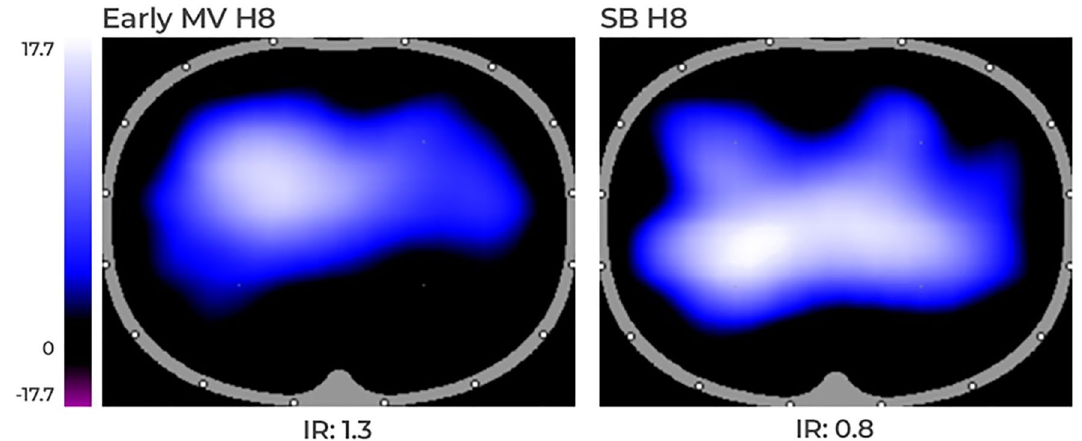
Figure 5. Representative images of an animal from the SB-group (right) and another from the Early MV group (left). The pulmonary ventilation distribution assessed by electric impedance tomography showed that SB presented dorsal predominant ventilation, as is shown by the impedance ratio = 0.8; in contrast, Early MV ventilation was predominantly ventral, as is shown by the impedance ratio = 1.3. IR impedance